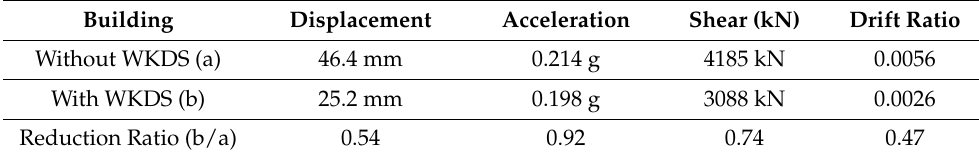
Table 5. Structural responses from nonlinear dynamic analysis.